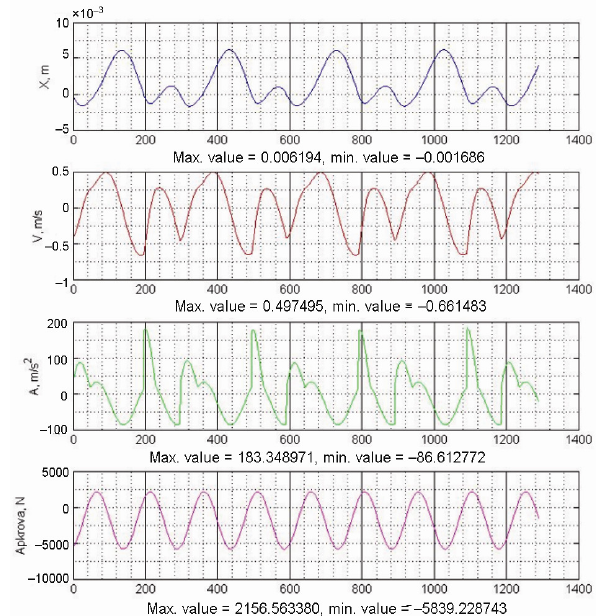
Fig. 9. Data processing interface of the pile